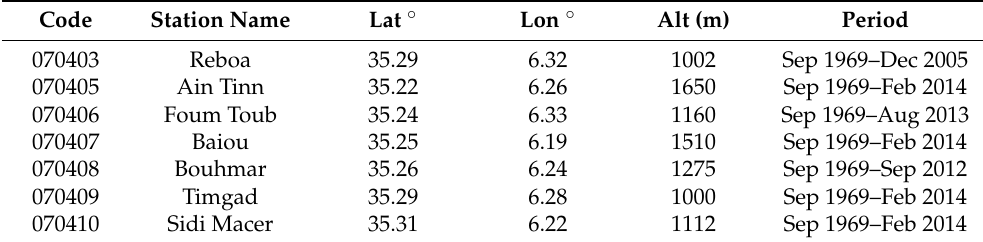
Table 1. Precipitation Gauge stations.